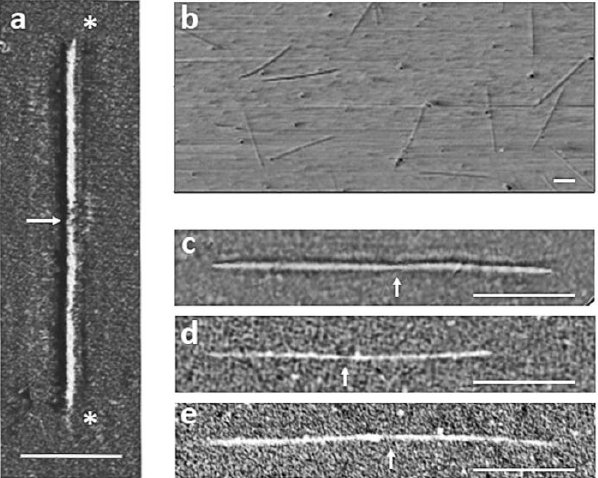
Figure 2. AFM images of isolated, native thick filaments on mica surface. ( a ) Most intact filaments (>67%) were identified by the presence of a bare zone near the halfway point (arrows) and tapered ends (*); ( b ) A wide field image reveals the relative homogeneity of isolated thick filaments. Representative thick filaments from fln + ( c ), fln Δ C44 ( d ), and fln Δ N62 ( e ) were captured during independent imaging sessions. Differences in contrast correspond to different tapping force applied to optimize each imaging session. Scale bars = 1 μm.